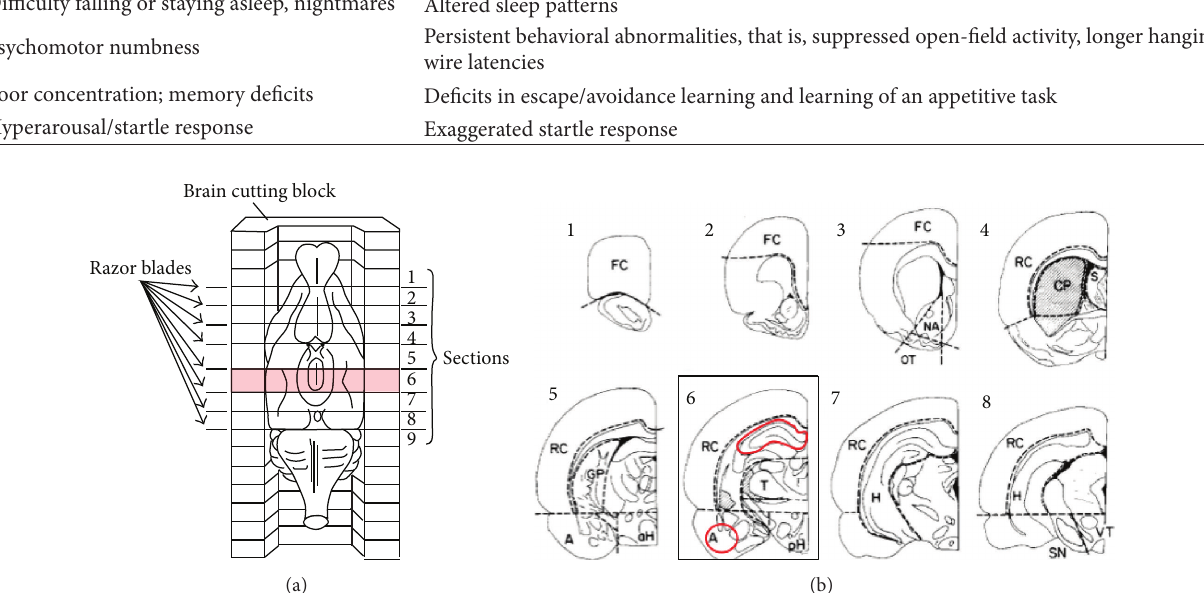
Figure 1: (a) Orientation of brain within brain cutting block; (b) coronal brain sections from dissected regions. (a) Illustration of rat brain in cutting block depicting specific areas where coronal slices were performed; (b) numbers correspond to dissected sections from (b). FC,